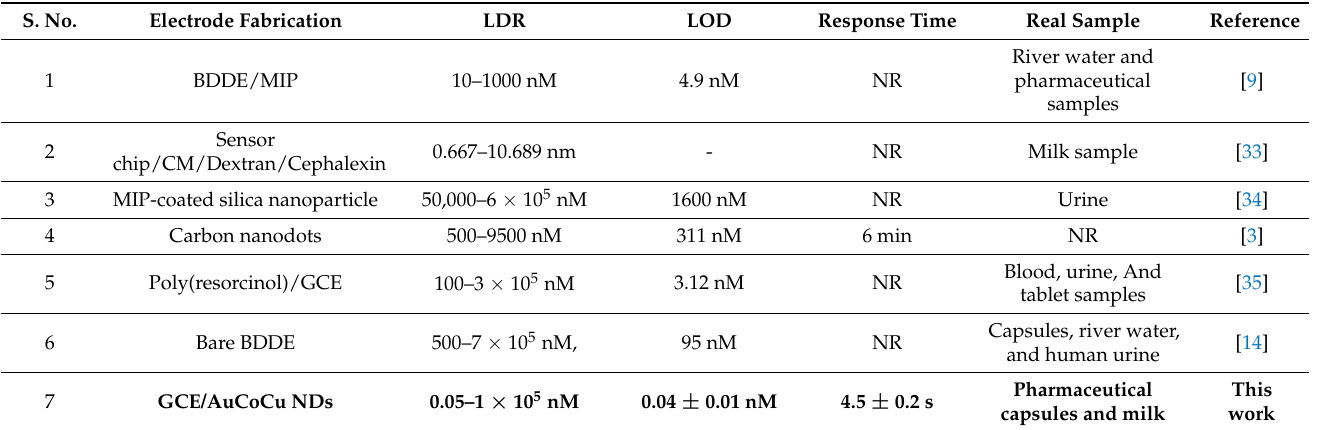
Table 1. Comparative analysis of nanoimprinted AuCoCu dendrites with the recently reported CFX sensors (NR).